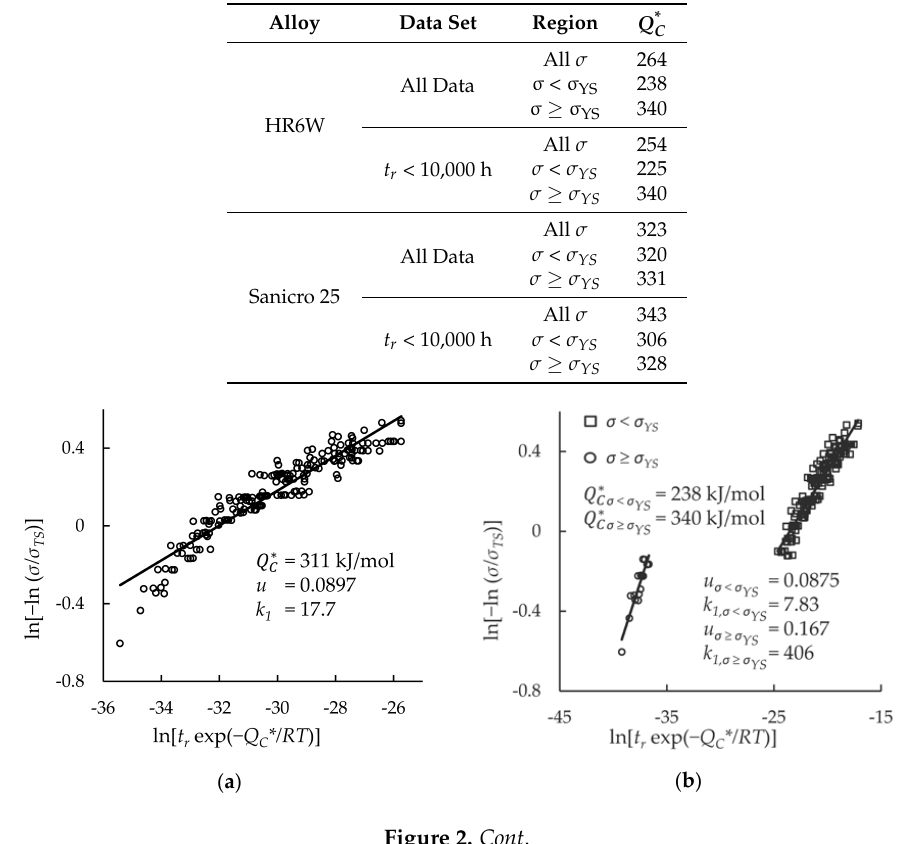
Table 3. Q ∗ C values (kJ/mol) determined by optimizing the correlation of data on Wilshire plots.